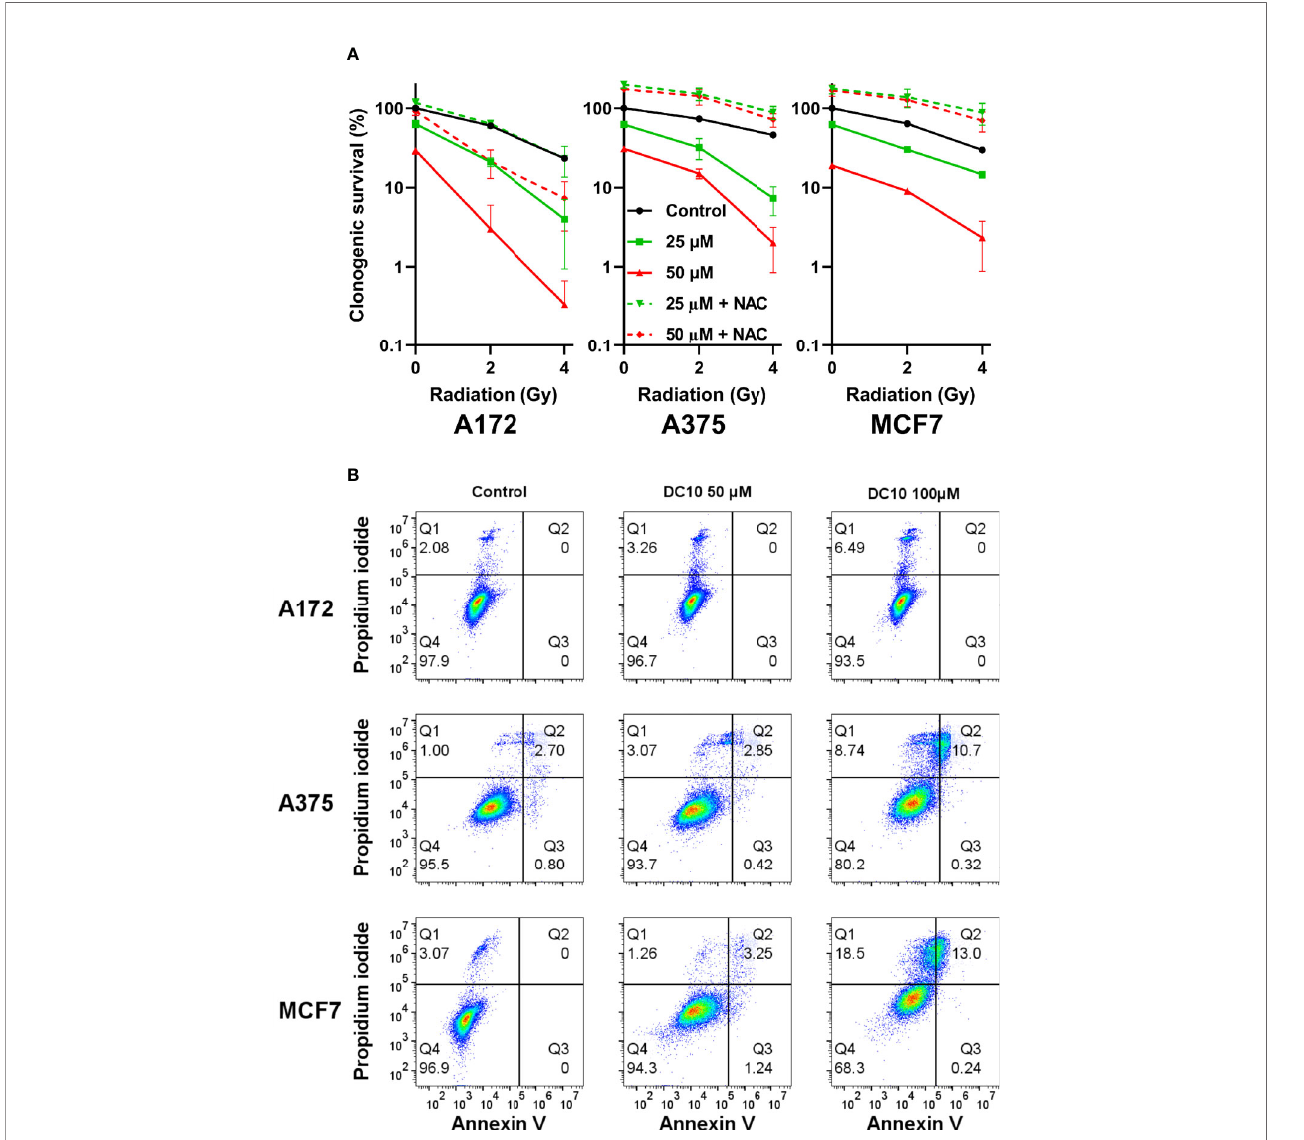
FIGURE 4 | Synergistic effect of DC10 and radiation on tumor cell colony formation (A) Clonogenic survival in cancer cell lines after 2 and 4 Gy radiation and treatment with 25 µM and 50 µM doses of DC10 in the presence or absence of NAC as indicated. (B) Scatter plot of untreated and DC10 treated cells stained for propidium iodide and annexin